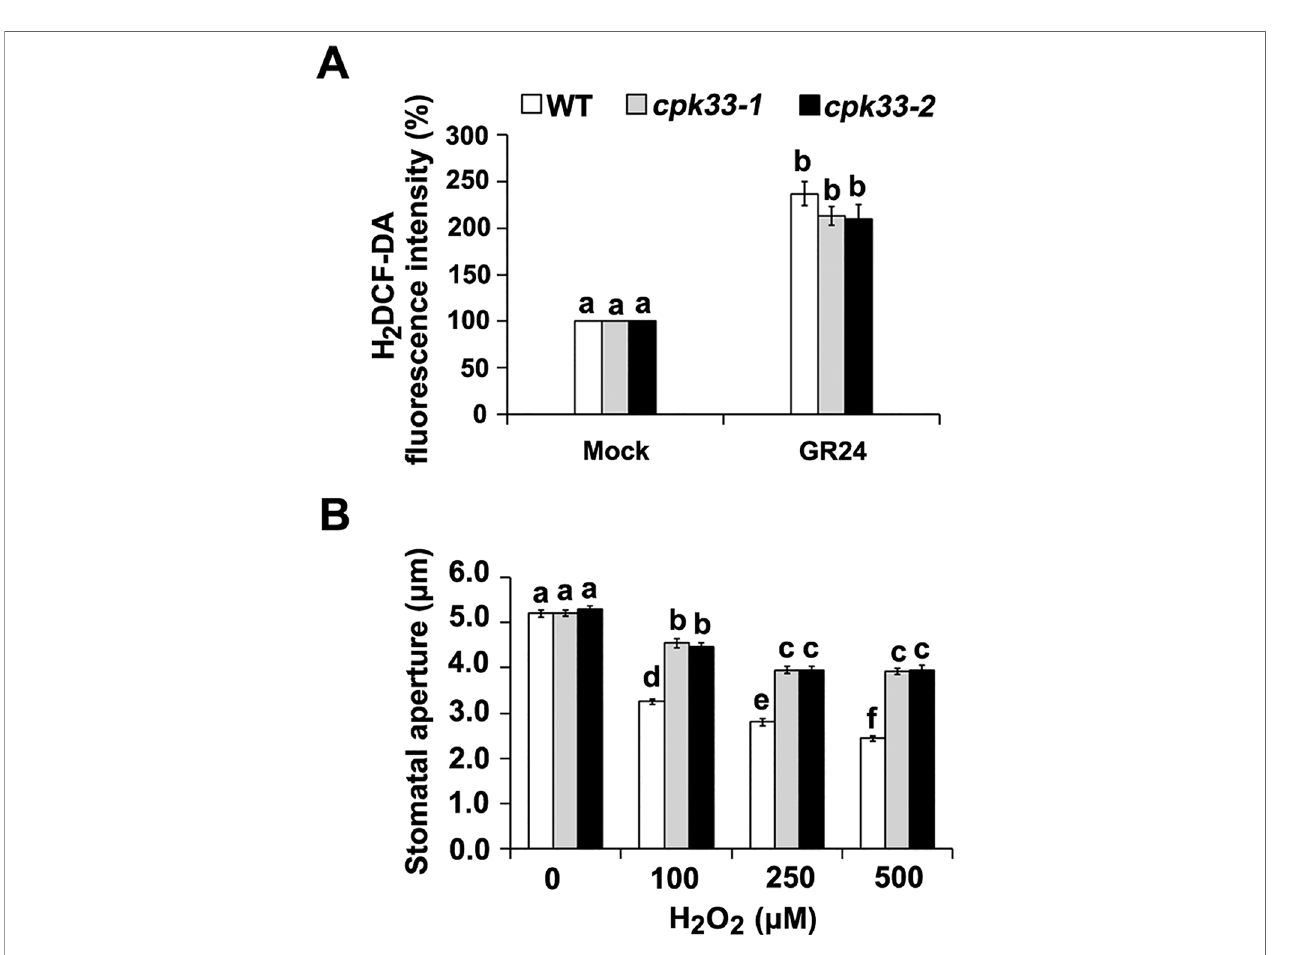
FIGURE 5 | The role of CPK33 in strigolactone-induced H 2 O 2 production and H 2 O 2 -mediated stomatal closure in guard cells. (A) Effects of GR24 on H 2 O 2 production in guard cells of WT plants, cpk33-1 and cpk33-2 mutants. Fluorescence intensities were normalized to those of controls that were taken as 100% for the indicated experiments. (B) Epidermal strips of WT plants with open stomata were exposed to the MES-KCl buffer containing different concentrations of H 2 O 2 . The stomatal apertures were measured and presented as means ± SE of three independent experiments. Bars with different letters represent statistically signi fi cant